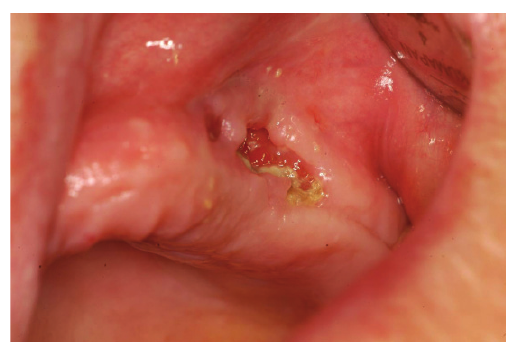
Figure 1: Stage III BRONJ in a female patient treated with alendronate for